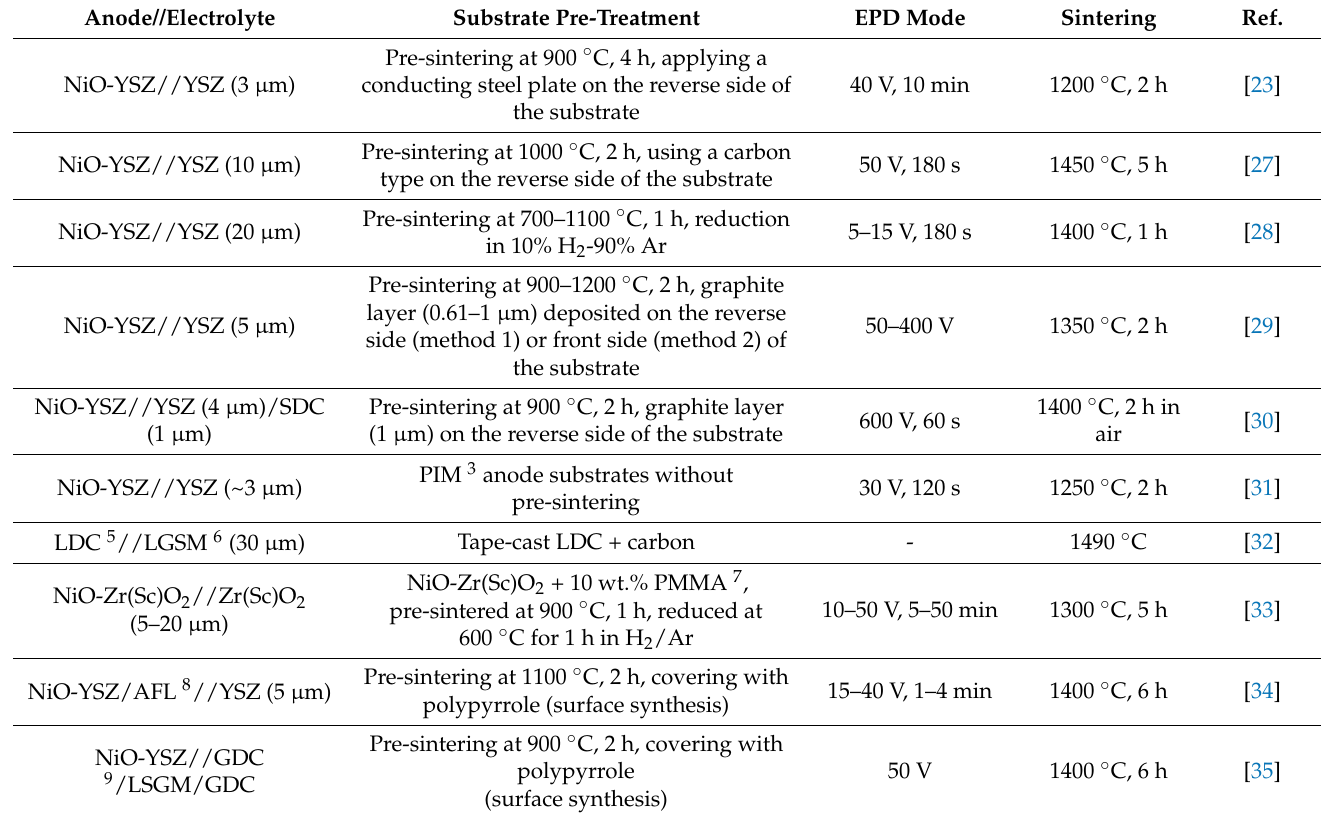
Table 1. Methods of the substrate preparation, EPD modes and sintering conditions of the electrolyte films fabricated on non-conductive anode